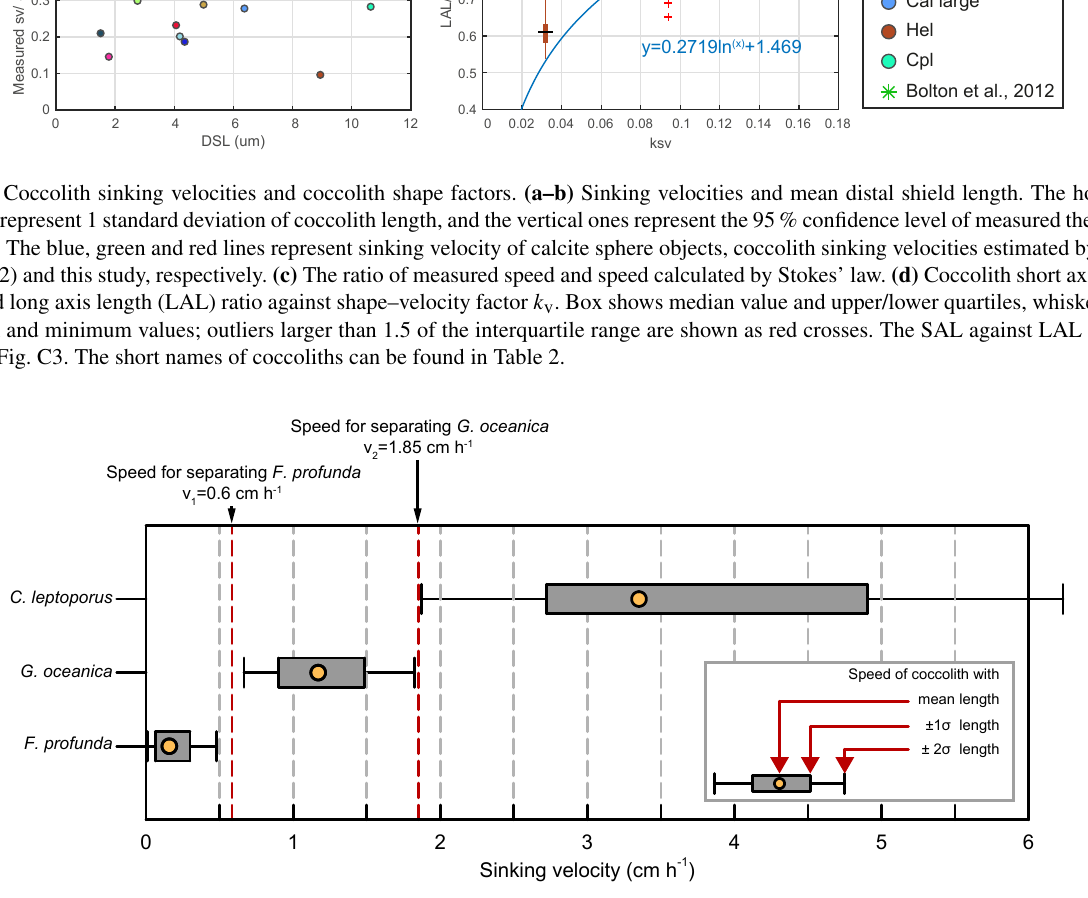
Figure 7. The selection of separation velocities: the sinking velocities of three main coccolith species in sample from core KX21-2 were calculated by the length distribution and velocity factors in Table 2. The yellow dots represent sinking velocities of coccoliths with mean length. The edge of boxes show the sinking velocities of coccoliths within 1 standard deviation of length ( ± 1 σ ), and the whiskers mark the sinking velocities of coccolith within 2 standard deviations of length ( ± 2 σ